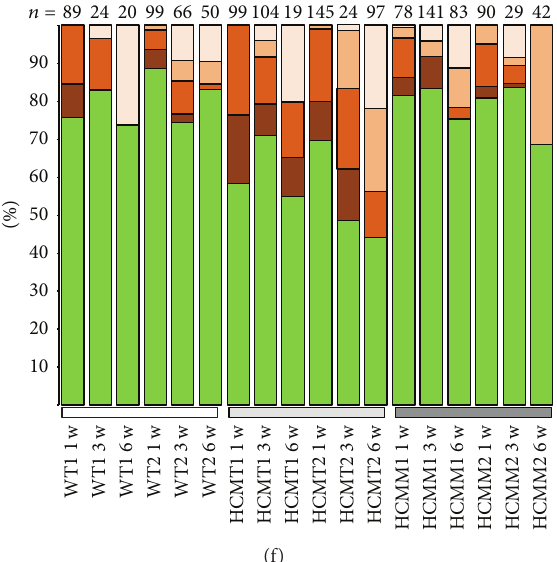
Figure 2: The cell size and Ca 2+ handling of hiPSC-derived CMs after 1-, 3-, and 6-week culture as single cells. (a) Representative images of WT-CMs (WT), HCMT-CMs (HCMT), and HCMM-CMs (HCMM) stained with antibodies for cTnT (red) and MYBPC (green) proteins. Scale bars are 100 𝜇 m. (b) The size of the HCMM-CMs was significantly larger in all three time points when compared to WT- and HCMT- CMs ( $$ 𝑝 < 0.005 when compared to WT-CMs or HCMT-CMs in the 1-week time point, ∗∗ 𝑝 < 0.005 when compared to WT-CMs or HCMT-CMs in 3-week time point, and ## 𝑝 < 0.005 when compared to WT-CMs or HCMT-CMs in 6-week time point). HCMT-CMs were significantly larger than WT-CMs in 3-week time point ( && 𝑝 < 0.005 when compared to WT-CMs. 𝑛 = 100 , except in HCMT 6 w 𝑛 = 96 .) (c) The proportion of the multinucleated CMs was significantly higher in HCMT-CMs than in WT-CMs and HCMM-CMs when both cell lines and all time points were combined for each group (in statistical analysis 𝑛 = 6 , ∗ 𝑝 < 0.05 ). The averages of multinucleated CMs were determined from the same cells, whose sizes and 𝑛 numbers are presented in (b). (d) Significantly more CMs with Ca 2+ handling abnormalities were observed in HCMT-CMs than in WT-CMs and HCMM-CMs when both cell lines and all time points were combined for each group (in statistical analysis 𝑛 = 6 , ∗ 𝑝 < 0.05 ). The proportions of CMs with abnormalities in their Ca 2+ handling were determined from the same Ca 2+ imaging results presented in (f). The total 𝑛 numbers of the analyzed CMs are presented in (f). (e) Representative images of Ca 2+ rhythm categories. (f) Distributions of hiPSC-derived CMs in different Ca 2+ rhythm categories (e) in each time point. WT1 = UTA.04602.WT, WT2 = UTA.04511.WT, HCMT1 = UTA.02912.HCMT, HCMT2 = UTA.13602.HCMT, HCMM1 = UTA.07801.HCMM, and HCMM2 =